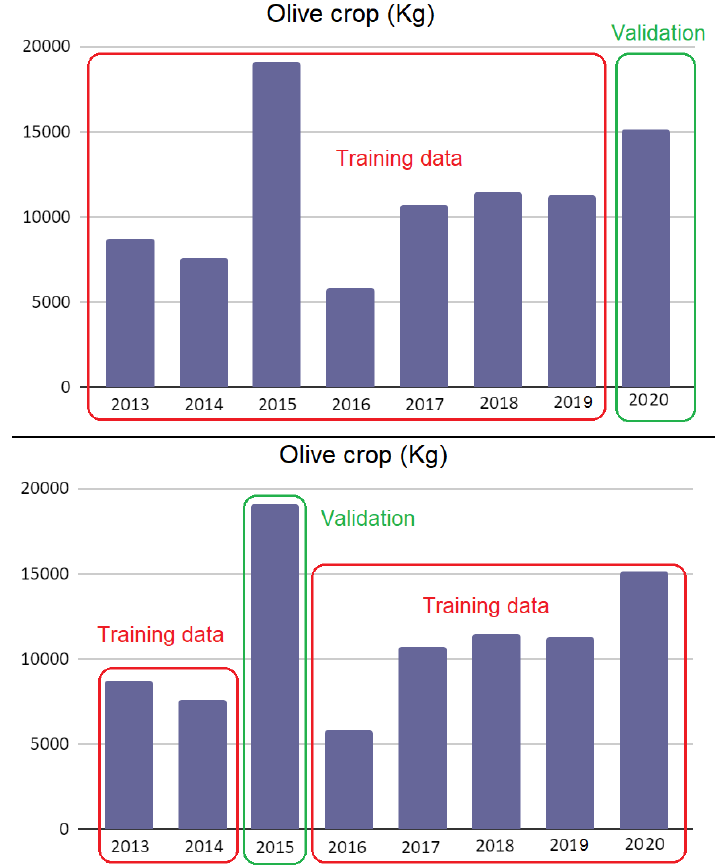
Figure 9. The k-fold cross validation technique applied to the yield data from 2013 to 2020. ( Up ) Training data used correspond from 2013 to 2019 and 2020 data are used for validation. ( Down ) Model is generated using training data from 2013 to 2020 not including 2015 data which is used for the validation process.